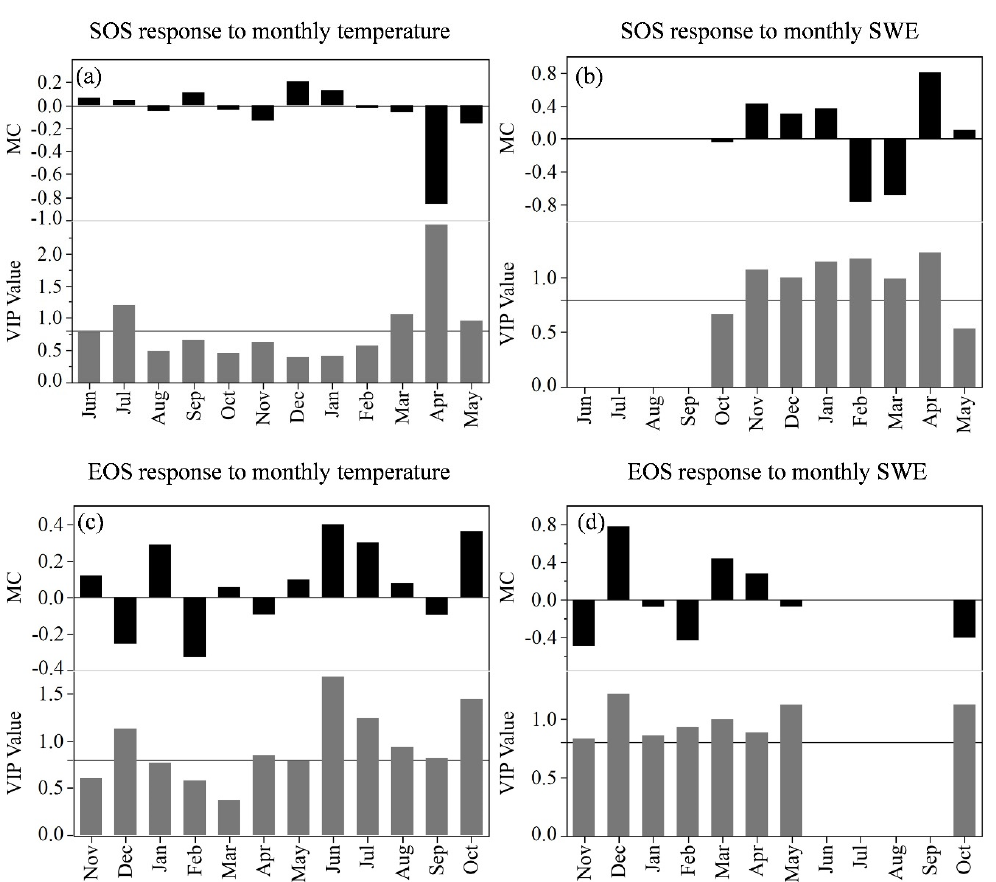
Figure 5. Responses of SOS and EOS in forest vegetation of the China–Mongolia–Russia International Economic Corridor to monthly temperatures ( a , c ) and monthly SWE ( b , d ) according to PLS regression.